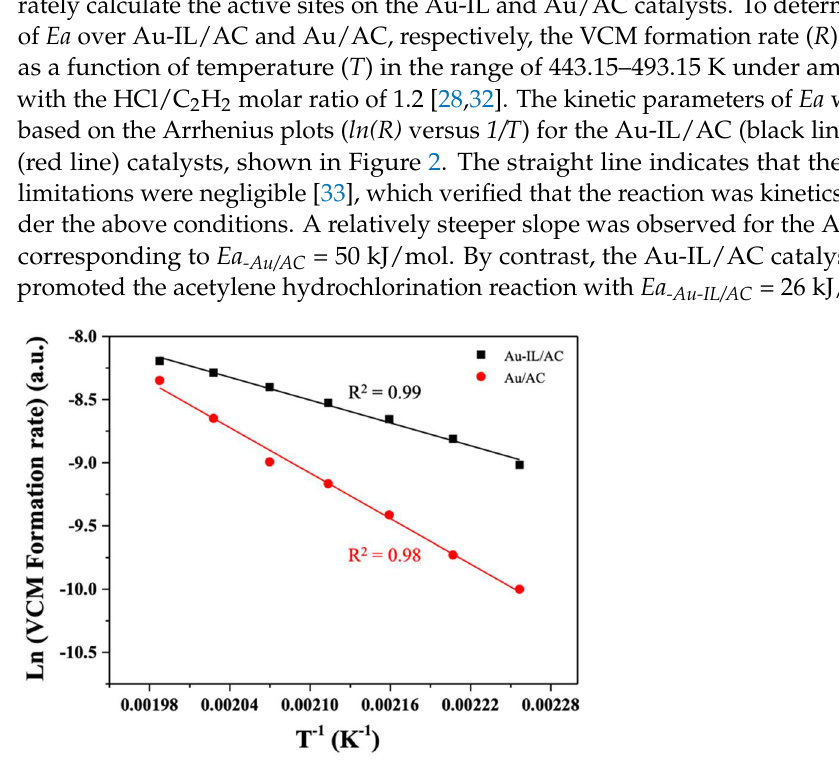
Figure 2. Arrhenius plot for the VCM formation rate over the 1 wt.% Au-IL/AC (black) and Au/AC (red) catalysts. The SDs for the black and red data are 0.29 and 0.52, respectively.